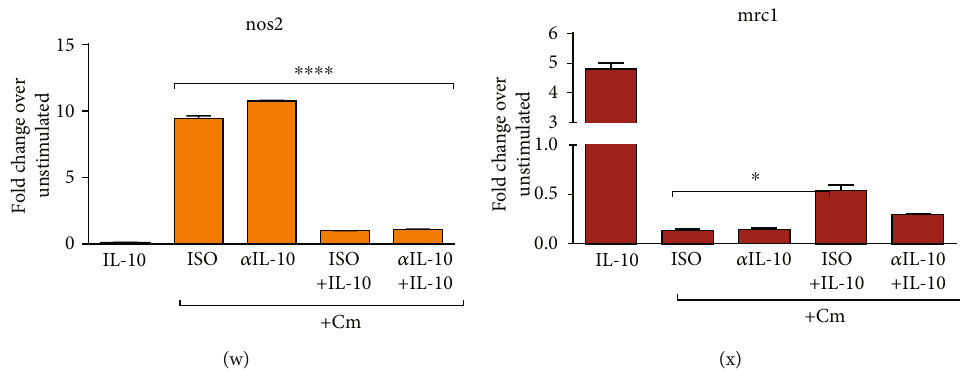
Figure 6: Skewing of the chlamydial M1 pro-in fl ammatory phenotype to an M2 anti-in fl ammatory phenotype by exogenous and endogenously produced IL-10. Macrophages (10 6 cells/mL) were stimulated with rMOMP (0.1, 1 and 10 μ g/mL) (A-C) or infected with Cm (MOI of 0.5, 1 and 2) (D-F) in the presence and absence of IL-10 (10 ng/mL). Macrophages were stimulated with rMOMP (1 μ g/mL; G-I) or Cm (MOI of 2; J-L) in the presence and absence of IL-10 (0.1, 1, and 10ng/mL). At 24h post-stimulation, the mRNA transcripts of the m1 marker; nos2 and m2 markers; arg1 and mrc1 were quanti fi ed using TaqMan qRT-PCR. The m1/m2 (M) and m2/m1 (N) ratios were calculated from macrophages exposed to rMOMP or Cm in the presence and absence of IL-10. Protein expressions of nos2 and mrc1 were evaluated from stimulated cells employing fl ow cytometry (O-T). Macrophages pre-incubated with neutralizing Abs to IL-10, IL-6, and TNF were stimulated with rMOMP or Cm for an additional 24h. Normal rat IgG1 Ab served as the isotype control (ISO). Post- stimulation, RNA was isolated to quantify the gene transcripts of nos2 and mrc1 (U-X) by TaqMan qRT-PCR. An asterisk indicates signi fi cant di ff erences ( P < 0.05), and P values were calculated as described in Figure 1. Each bar represents the mean ± SD of samples run in triplicates, and each experiment was repeated at least 3 to 4 times with a representative experiment